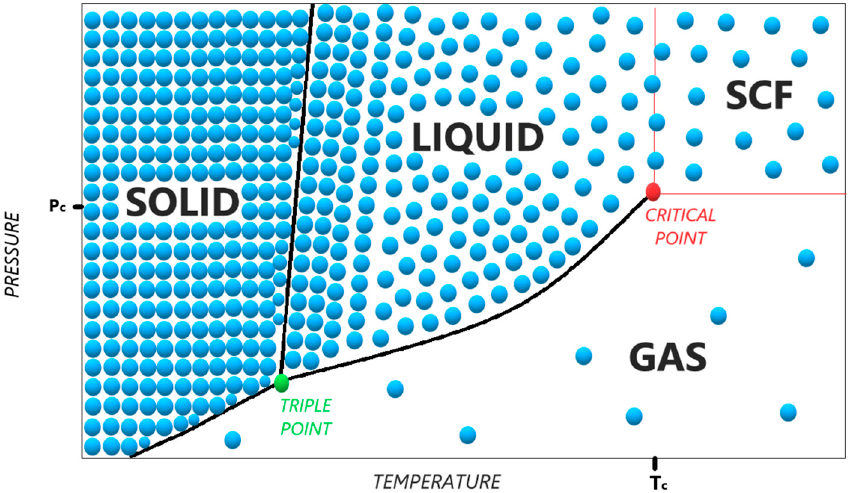
Figure 1. Schematic phase diagram of the dependence of the density changes of the medium depending on the pressure and temperature. Density changes are graphically represented as changes in the blue dot density.